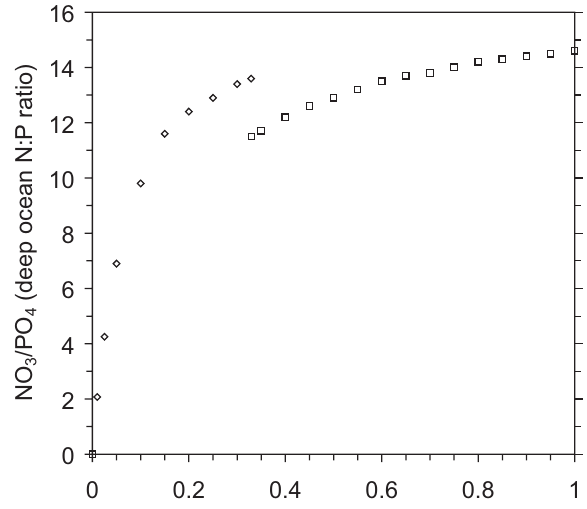
Fig. 6. Numerical solutions for the dependence of the deep ocean N:P ratio on the N:P Redfield ratio of either N 2 -fixing organisms, R NF (squares) or other non-fixers, R O (diamonds), in the extended TT model. When varying one Redfield ratio the other is held con- stant at 16. A stable steady state could not be found for R O =7 or less.